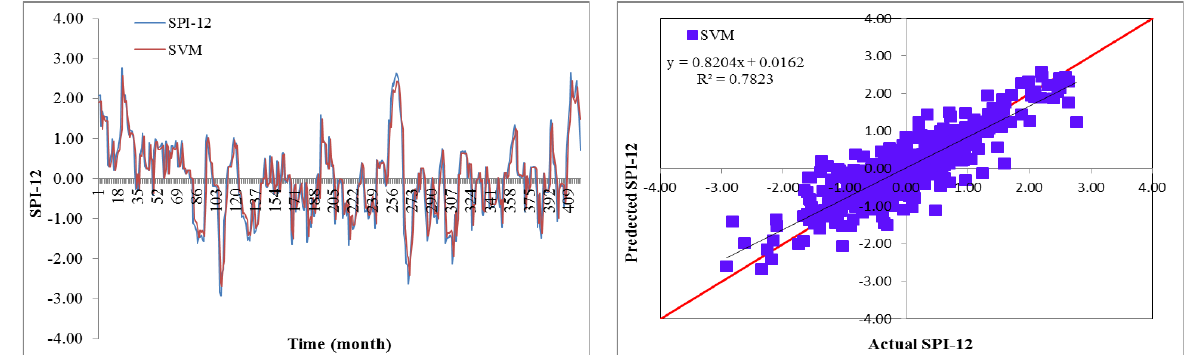
Figure 10. Plots showing the predicted and observed SPI values for 3, 6, 9, and 12 month timeframes during validating the performance at sub-basin 2.